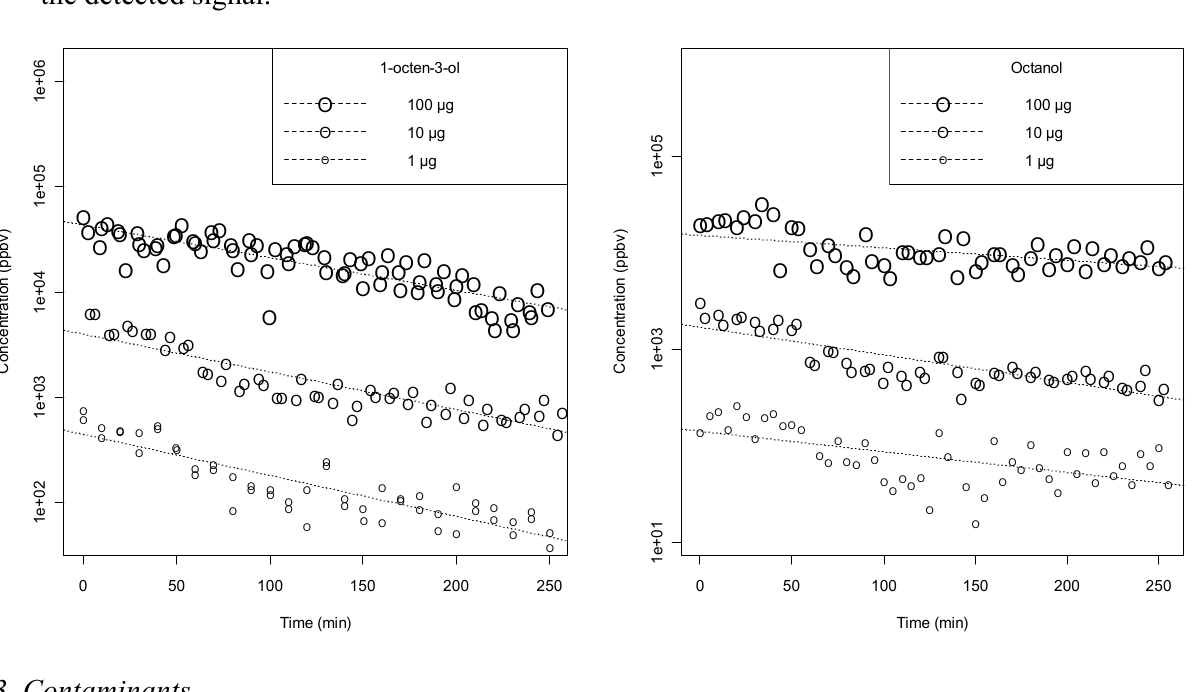
Figure 5. Effect of the starting concentration of the stimulus compound in the cartridges on the detected